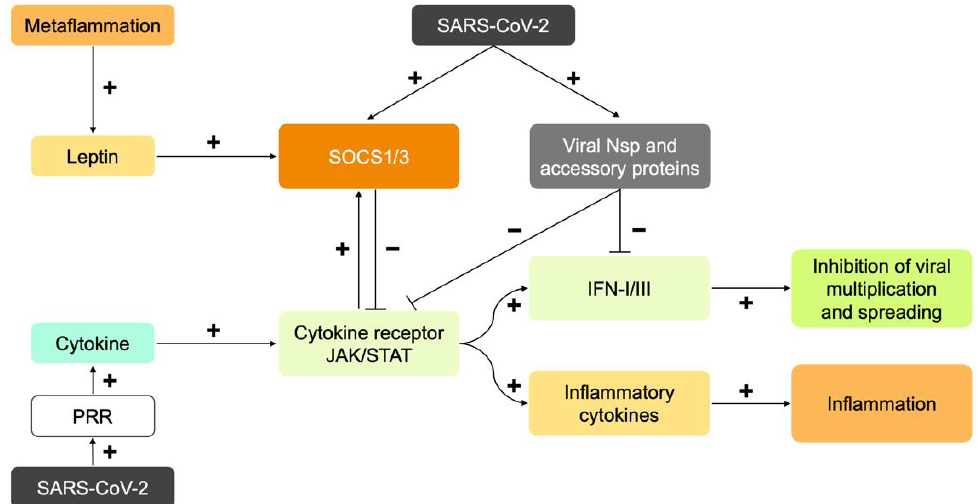
Figure 1. Schematic representation of the immune response and its dysregulation by metaflammation and SARS-CoV-2. The virus is recognized by pattern recognition receptors (PRR). PRRs are located on the membrane and in the cytoplasm. Through the secretion of cytokines, the infected cell warns other cells to inhibit virus multiplication and spreading (via interferons; IFN-I and -III) and initiate an inflammatory response (via inflammatory cytokines such as TNF- α and IL-6). Signal transduction by cytokines takes place via a cytokine receptor and the Janus kinase/Signal Transducer and Activator of Transcription protein (JAK/STAT) pathway. This pathway creates its own boundary by also expressing the proteins “Suppressor of Cytokine Signaling 1 and 3” (SOCS1/3). These inhibit the JAK/STAT pathway via negative feedback. Metaflammation is characterized by chronic low-grade inflammation. In obesity, the inflamed adipose tissue chronically secretes pro-inflammatory cytokines, including leptin. Leptin and insulin resistance are generated through the inhibition of the JAK/STAT pathway by expression of SOCS1/3. Therefore, in metaflammation, there is already a brake on cytokine signaling before infection. The RNA of SARS-CoV-2 contains codes for non-structural (Nsp) proteins and “accessory” proteins. Infected cells express these proteins. They inhibit the induction and activation of IFN-I. The virus also causes the expression of SOCS1/3. The inhibition of IFN-I signaling by the virus, virus-mediated induction of SOCS1/3, and the preexisting elevation of SOCS1/3 in metaflammation, collectively cause late and initially weak IFN-I and -III responses, and a strong multiplication and spreading of the virus. Major damage is caused by the virus and the immune system. The resulting immune system overreaction, cytokine storm and hypercoagulation are hallmarks of a severe COVID-19 course.